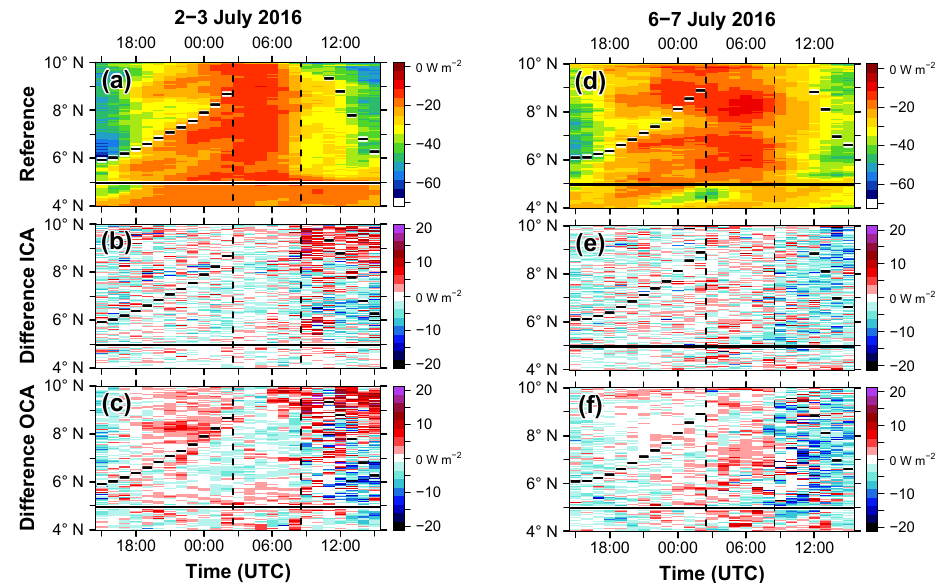
Figure 10. Same as Fig. 9 but for SLR and SLR difference (Wm − 2 ): (a, c) reference, (b, d) reference minus No-ALWC for ICA and (c, f) reference minus No-ALWC for OCA. Positive (negative) values in (b) , (c) , (e) and (f) denote more outgoing longwave radiation in the reference